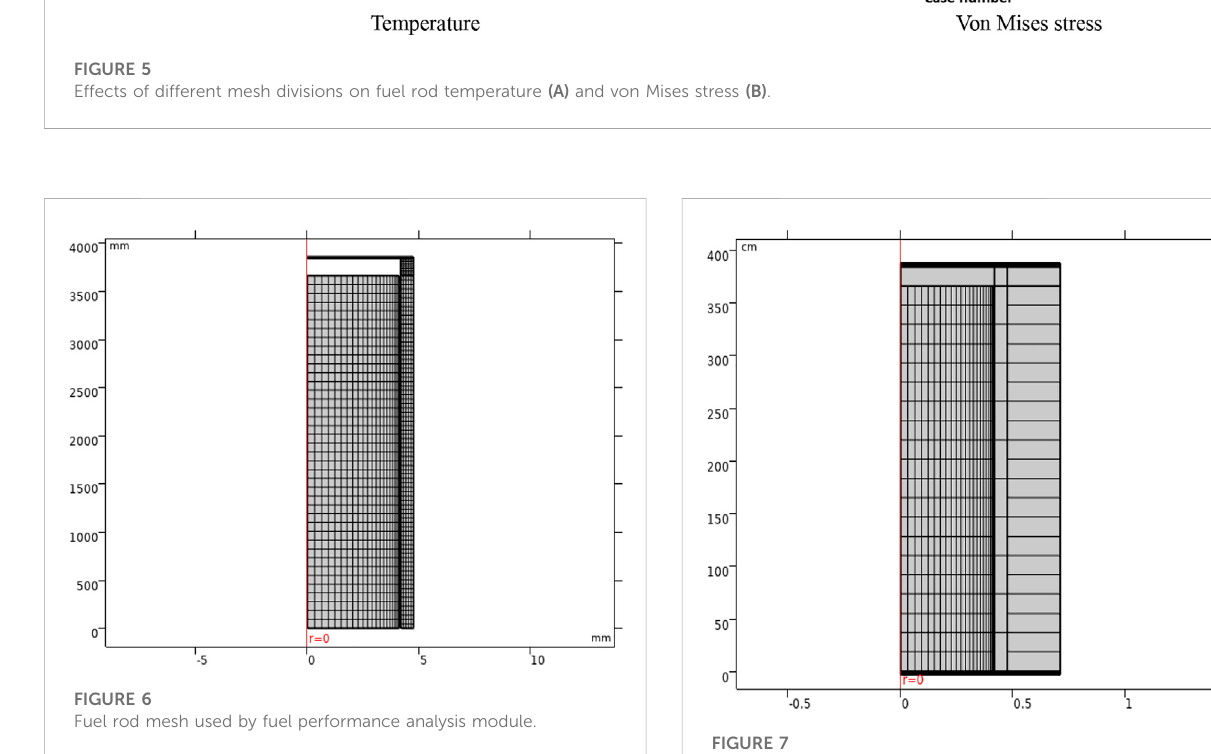
FIGURE 7 Proxy mesh of RMC in COMSOL.